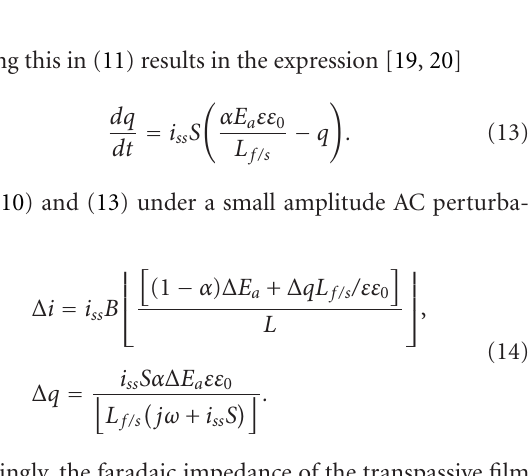
Figure 5: A Scheme representation of the processes in the metal/transpassive film/solution system, according to PDM.